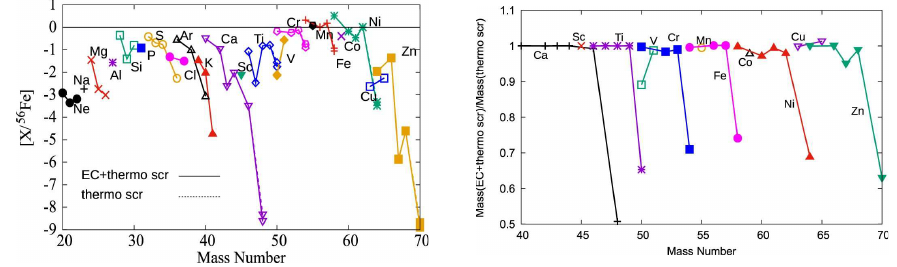
Figure 1. (Left) Abundances normalized by the solar and 56 Fe abundances obtained for the W7 model of SNe Ia. Solid and broken lines show results with and without the SCR e ff ects, respectively. (Right) Abundance ratios between the cases with and without the SCR e ff ects on e-capture rates obtained for the W7 model. Taken from [16].